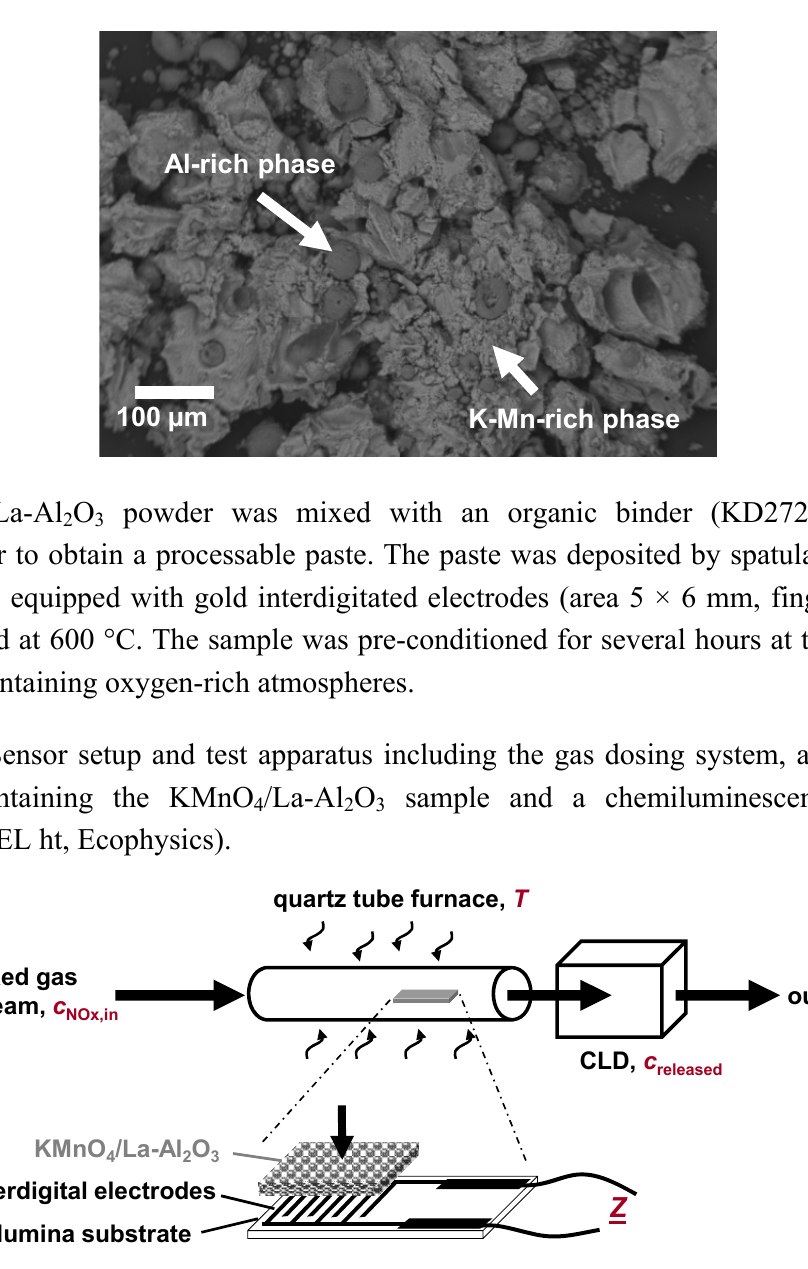
/La-Al O powder after firing. The Al-rich particles 4 2 3